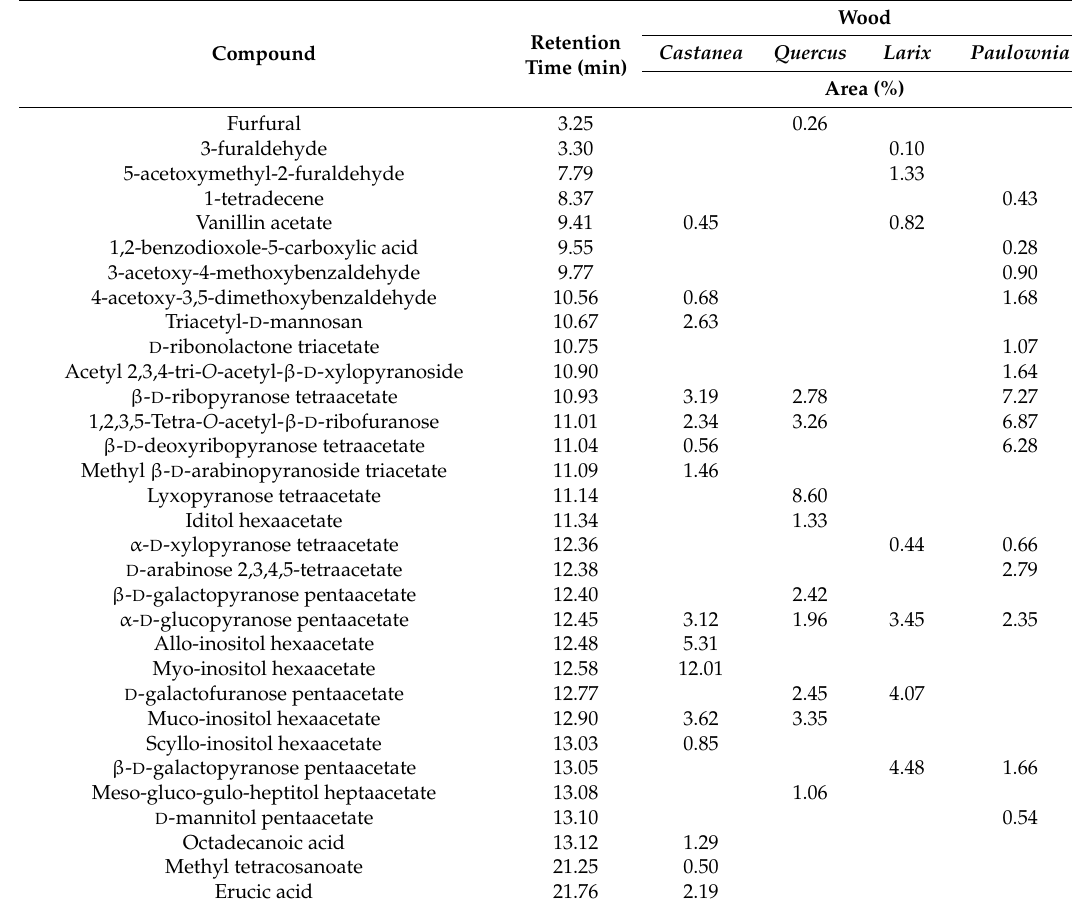
Table 3. GC-MS analysis of chloroform insoluble water extractives after acetylation (results presented in area